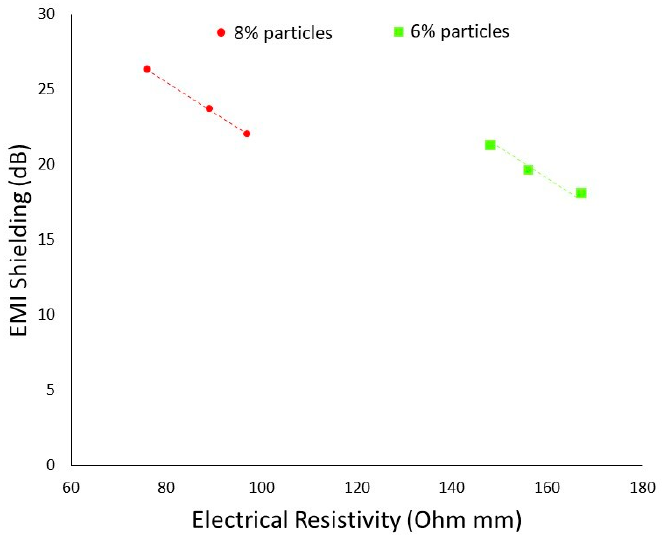
Figure 15. The comparison between electrical conductivity and EMI shielding for composite sam- ples made by 6 and 8 percentage of carbon particles. made by 6 and 8 percentage of carbon